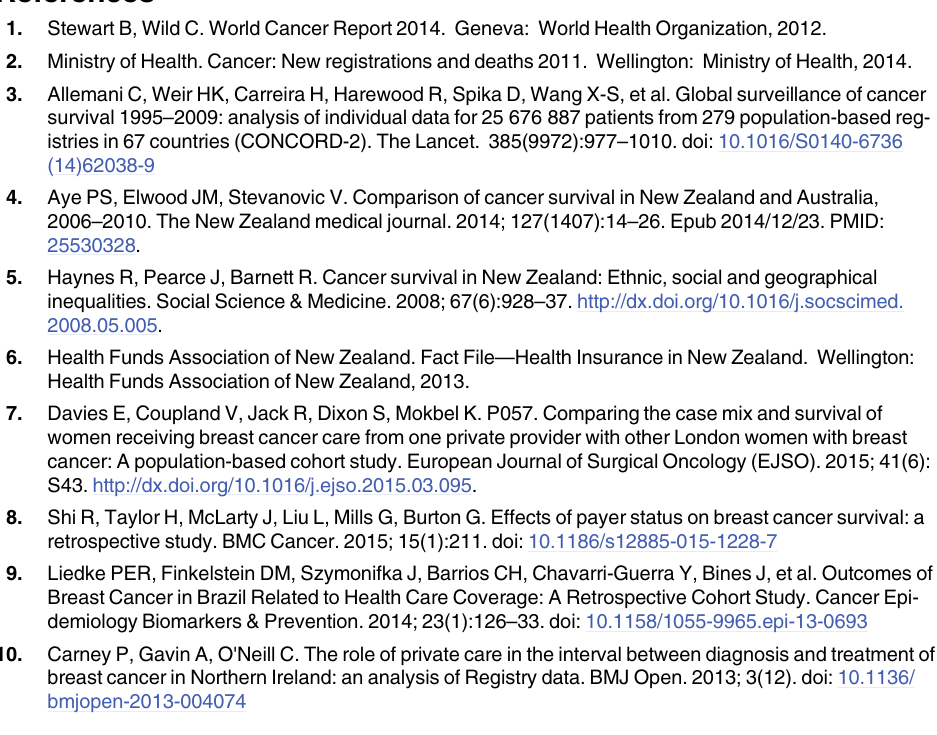
S1 Table. Hazards of death from breast cancer in hormone receptor positive and negative patients by health care facility type with stepwise adjustments. S2 Table. Hazards of death from any cause by health care facility type with stepwise adjust-